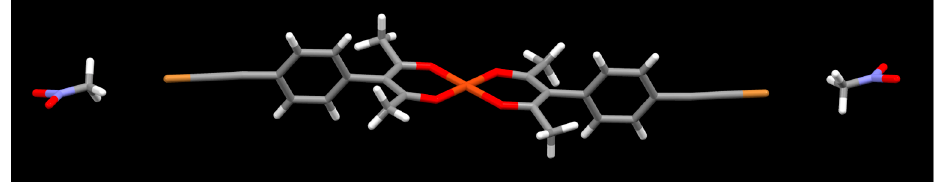
Figure 10. Part of the crystal structure of [Cu( L2 ) 2 ]·2CH 3 NO 2 showing the geometry around the metal ion and the packing of ligand and solvent (color codes: red—oxygen; blue—nitrogen; gold—bromine; orange—copper).